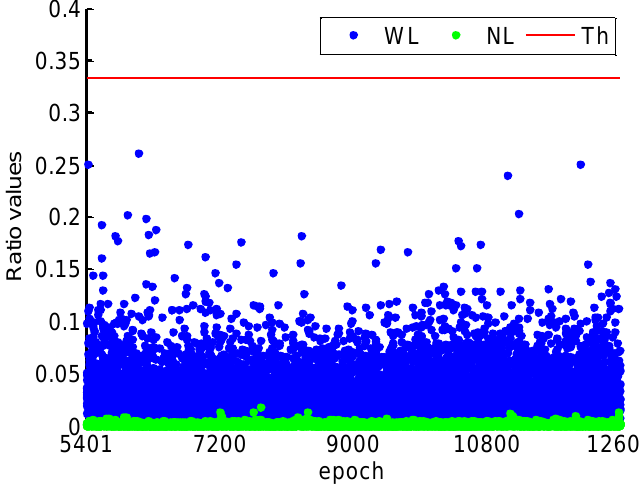
Figure 3. WL and NL ratio values for 1 s.